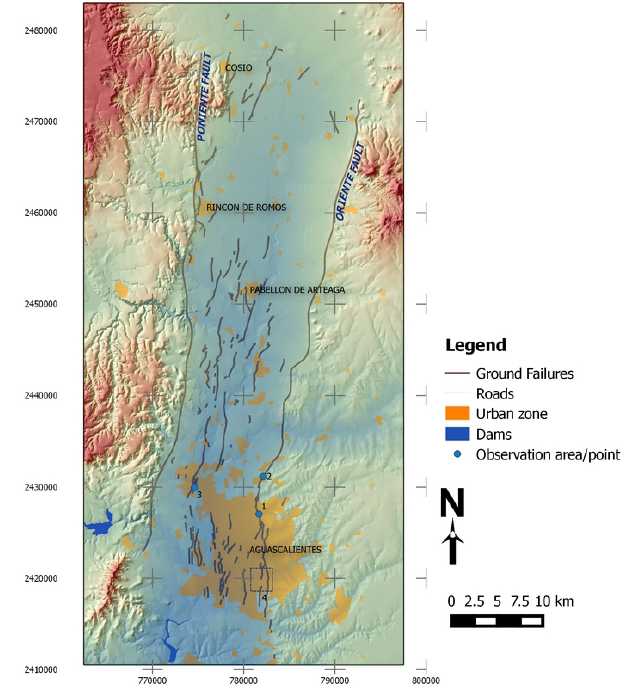
Figure 1. Main features of the Aguascalientes basin. Areas and points of observation in the map are referred according to figures: point 1 to Fig. 2, area 4 to Fig. 3, point 2 to Fig. 4, and point 3 to Fig. 5.